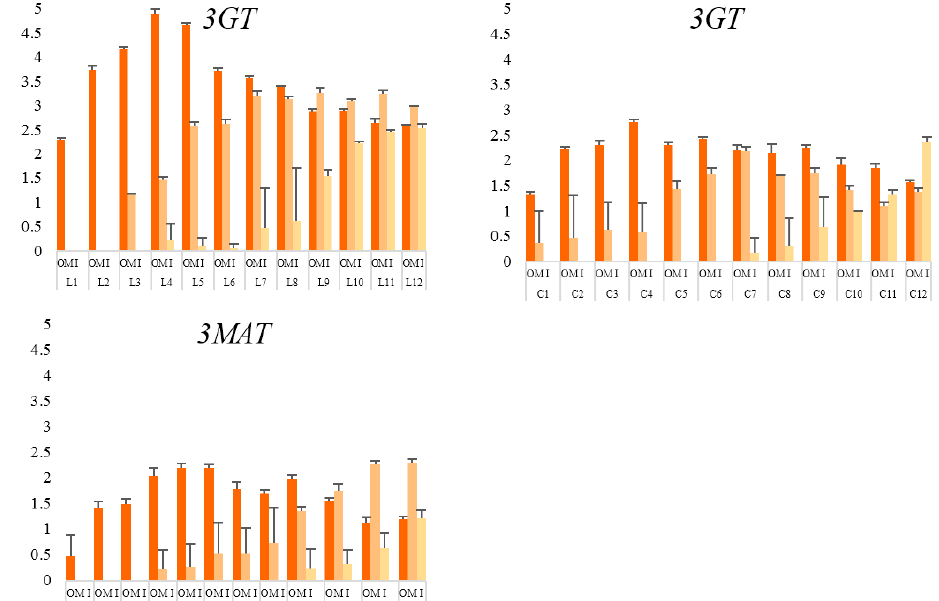
Figure 5. Gene expression patterns of two varieties of Ranunculus asiaticus L. L1–L2: stage 1–stage 12 of ‘Jiaoyan zhuanhong’ (Figure 1); C1–C12: stage 1–stage 12 of ‘Jiaoyan yanghong’; O: outer petal; M: middle petal; I: inner petal; c72570 , c130622 , and c83020 were unigenes annotated as encoding 3GT, 3GT, and 3MAT based on transcriptome sequencing.